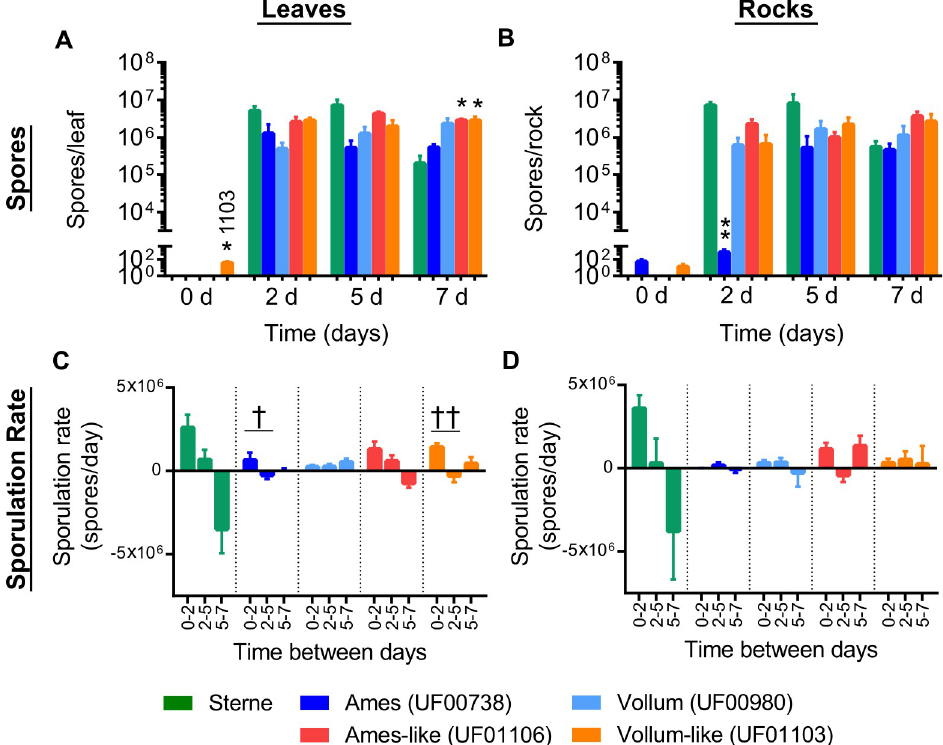
Fig 5. Differences in spores and sporulation rates from leaves and rocks over 7 days between Sterne strain and fully virulent strains of B . anthracis . (A) Total spores recovered from leaves, (B) total spores recovered from rocks, (C) sporulation rates on leaves, and (D) sporulation rate from rocks for the Sterne (green), Ames (UF00738, dark blue), Vollum (UF00980, light blue), Ames-like (UF01106, red) and Vollum-like (UF01103, orange) strains are presented as the mean ± SEM. Sporulation rates (spores/day) were calculated from the slope of the lines between each timepoint and graphed on a linear scale. Significant differences in total spores between the Sterne strain and all fully virulent strains were determined by Kruskal-Wallis and Dunn’s multiple comparisons tests with differences identified by � = ρ < 0.05, �� = ρ < 0.01. Significant differences in sporulation rates between days were determined by Kruskal-Wallis and Dunn’s multiple comparisons tests with leaf temporal differences identified by † = ρ < 0.05, †† = ρ <